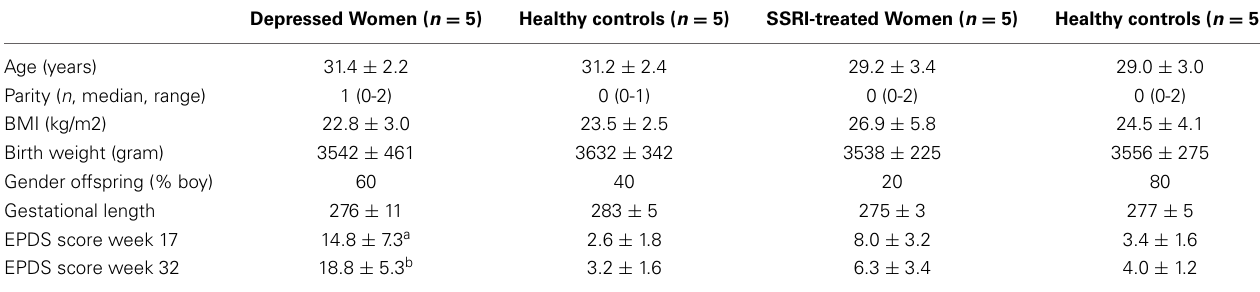
Table 1 | Microarray demographic variables in the depressed group, SSRI group, and healthy